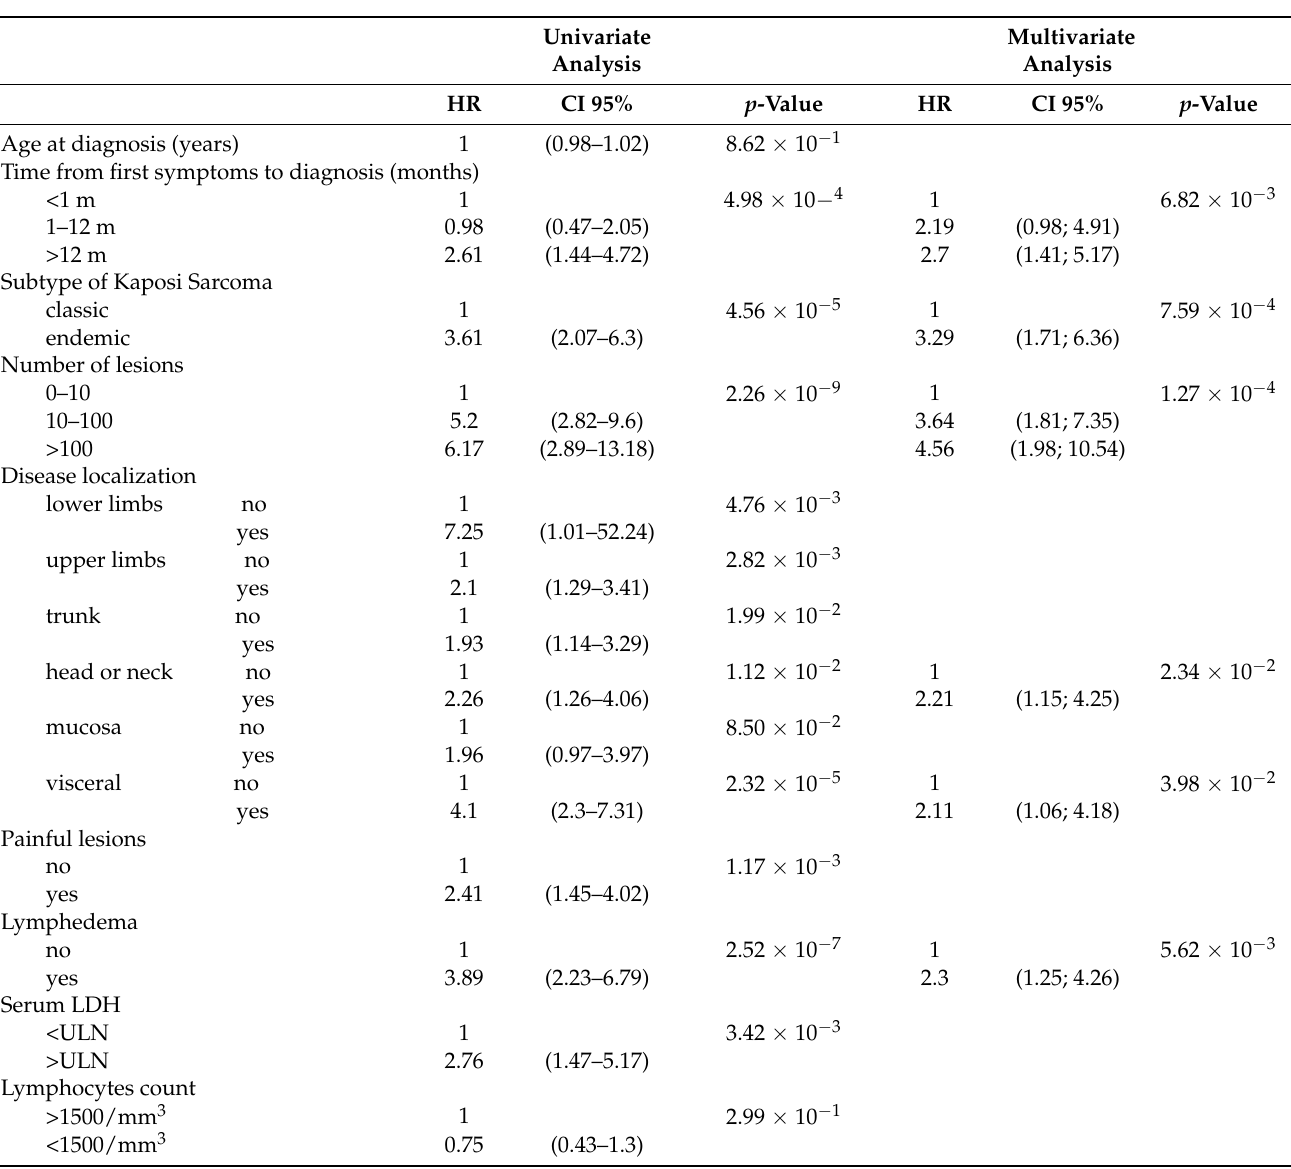
Six risk factors for systemic treatment initiation were identified with multivariate analysis: endemic versus classic KS (HR: 3.29 [95% CI: 1.71; 6.36]), total number of